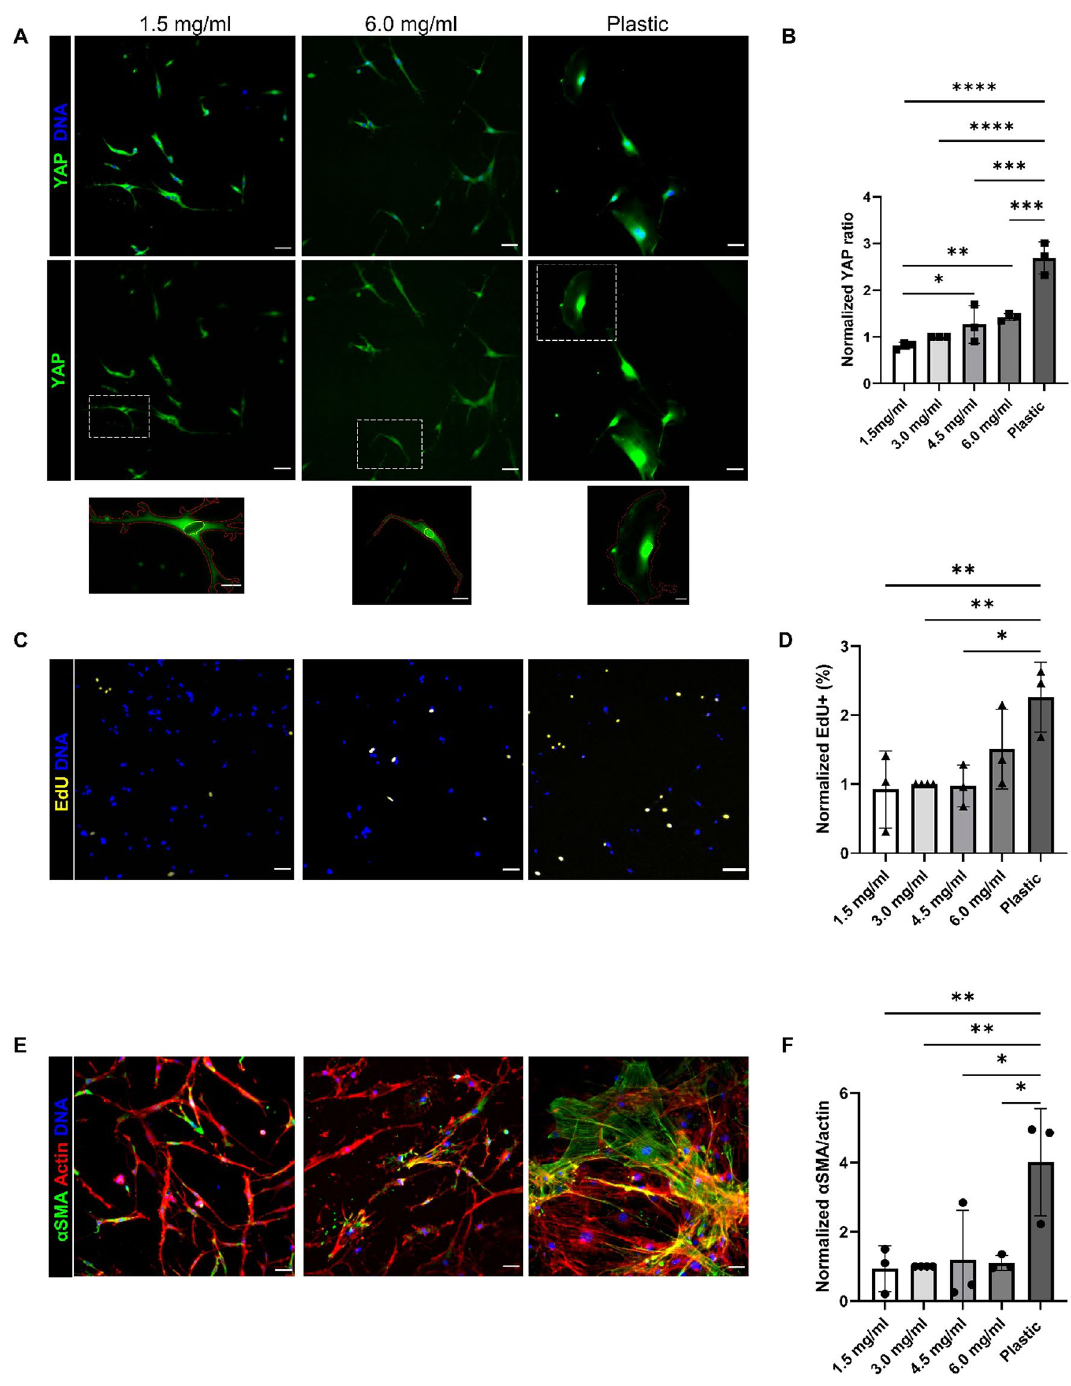
Figure 2. FAP behavior in response to scaling collagen concentration. ( A ) YAP immunofluorescence of FAPs on 1.5 and 6.0 mg/ml collagen gels and tissue cultured plastic. Yellow outlines indicate nuclei and red outlines indicate cytoplasm on insets. ( B ) Quantification of YAP signal intensity as a nuclear to cytoplasmic ratio. ( C, D ) EdU signal and quantification across collagen concentrations and plastic. ( E ) αSMA signaling in FAPs after 7 days in FAP media. ( F ) Quantification of αSMA and actin area ratio as a measure of myofibroblast activation. * P < 0.05, ** P < 0.01, *** P ≤ 0.001, **** P < 0.0001, One-way ANOVA with multiple comparisons with Dunnett correction. Data normalized to 3.0 mg/ml. Scales bars set to 50 μm. Scale bars for insets set to 20 μm. N = 3 and n = 3 for 1.5, 4.5, 6.0 mg/ml and plastic. N = 4 and n = 4 for 3.0 mg/ml. N = number of mice, n = number of independent